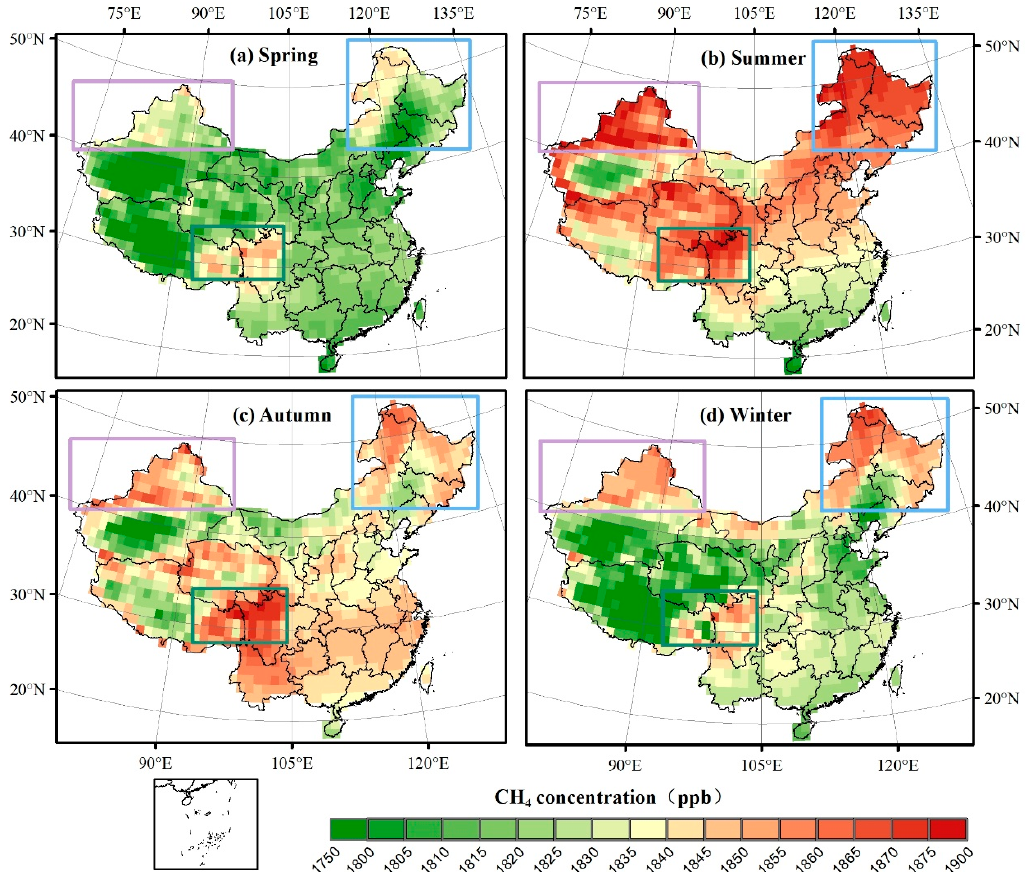
Figure 5. Spatial distributions of the seasonal averages of CH 4 concentration at 500 hPa across China in the four seasons: ( a ) spring, ( b ) summer, ( c ) autumn, and ( d ) winter (the pink box represents Region I: northern Xinjiang; the blue box represents Region II: northeast of Inner Mongolia/Heilongjiang; the green box represents Region III: northwest Sichuan) .